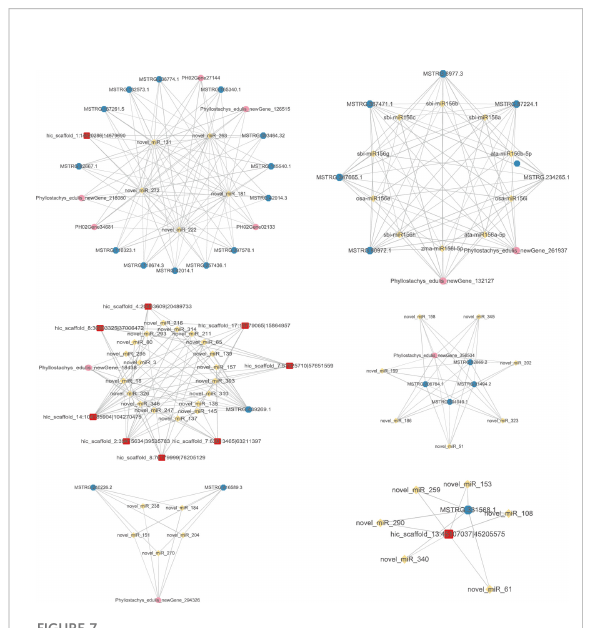
FIGURE 7 The mRNA-miRNA-circRNA-lncRNA interaction network of P1 treatment with drought treatment P4. Yellow nodes: miRNAs. Red nodes: circRNAs that may be miRNA decoys. Blue nodes: lncRNAs that may be miRNA decoys. Pink nodes: mRNAs that may be miRNA